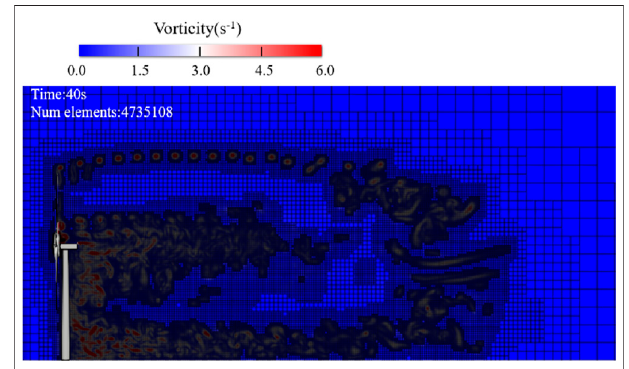
FIGURE 5 | Screenshot of the adaptive mesh elements of the NREL 5 MW turbine at t = 40 s during a calculation.